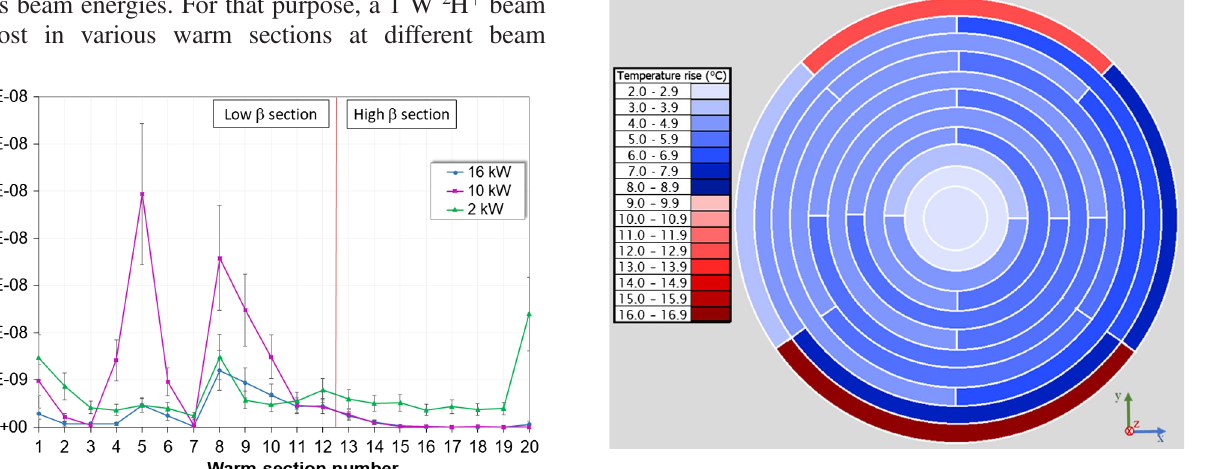
FIG. 21. Beam view of SAFARI. The colors represent the temperature rise in each thermocouple at 16 kW, light blue colors lower temperatures and red colors higher